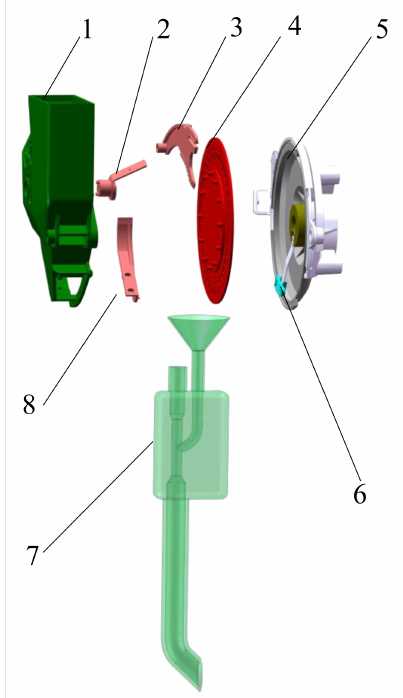
Figure 1. Air-assisted high-speed precision seeding and seed-delivery system: (1) case, (2) lower clearing knife, (3) upper seed cleaning knife, (4) seed disk, (5) negative pressure chamber, (6) air barrier plate, (7) seed-delivery device, (8) forced cleaning